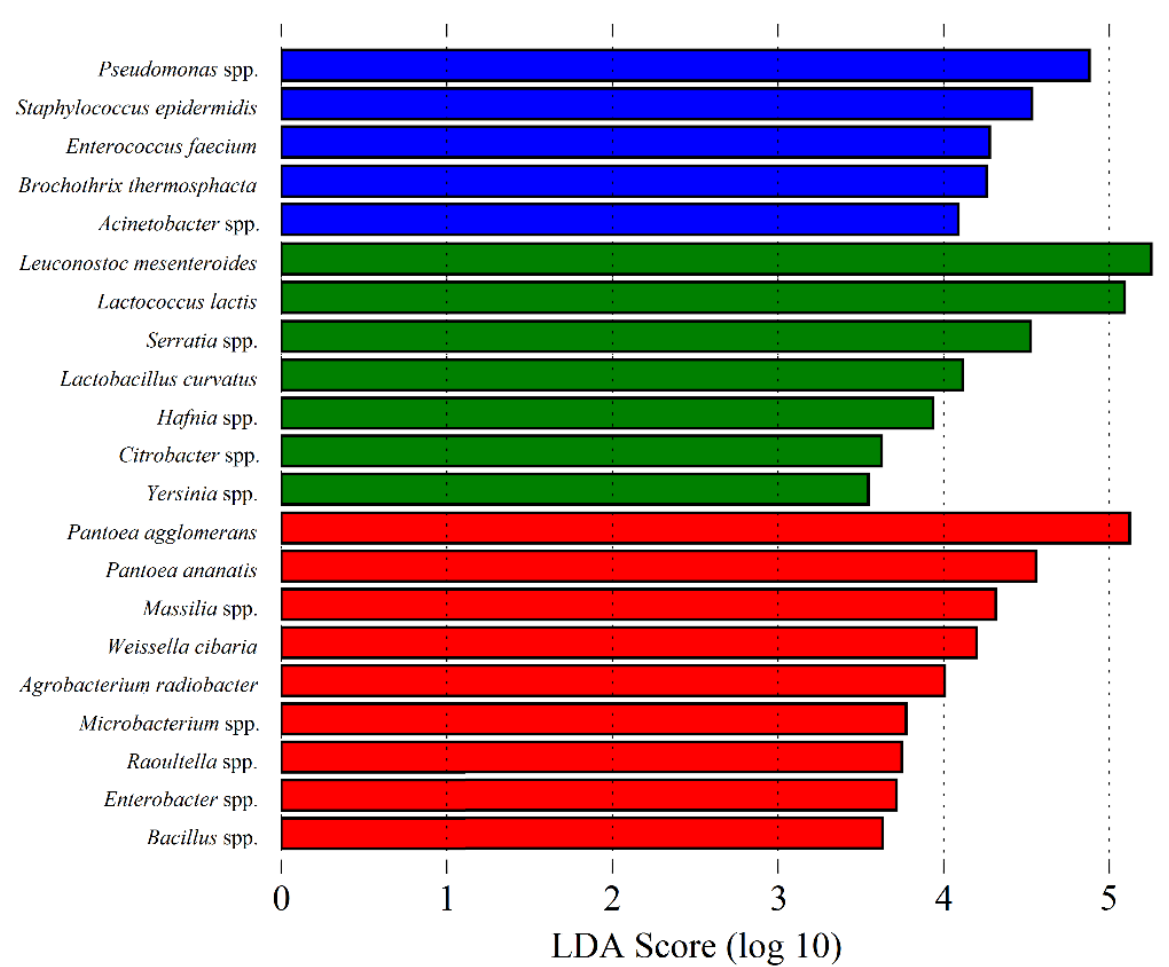
Figure 7. Linear Discriminant Analysis (LDA) scores computed for bacterial features differentially abundant in: raw ewes’ milk (blue bars); Serra da Estrela cheese (green bars); and dried flowers of Cynara cardunculus L. (cardoon (red bars)).